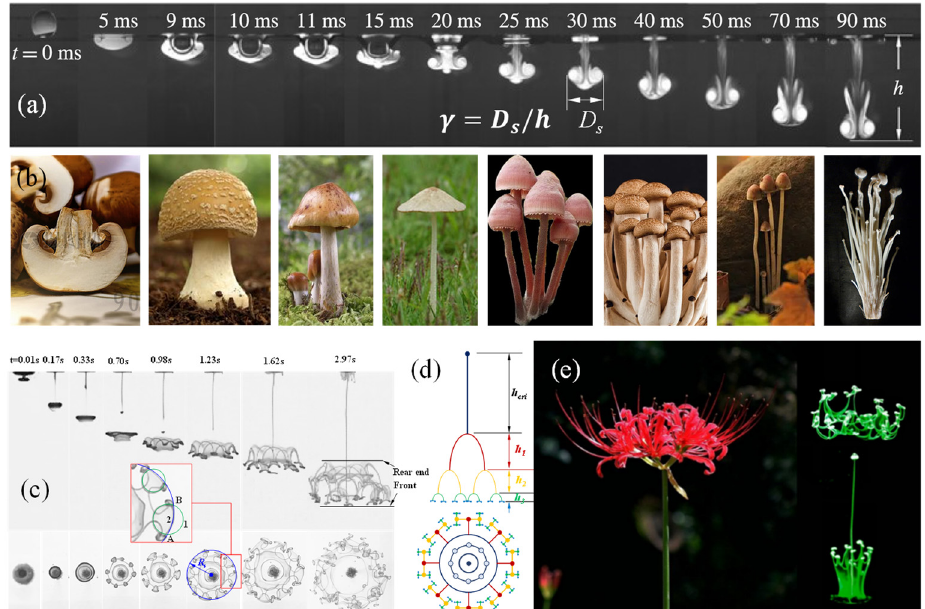
Figure 1. ( a ) Comparison of the morphologies of sinking vortex ring [31] “Reprinted with permission from [Abhishek Saha et al.], [The Journal of Fluid Mechanics]; published by [Cambridge University Press], [2019]” with ( b ) mushrooms, ( c ) High speed images showing side and bottom view of the morphological evolution of the vortex ring and ( d ) its abstract structure, ( e ) Morphologies of manjusaka vs. the bifurcation flower [32]. “Reprinted with permission from [Yajie Zhang et al.], [Physica of Fluids]; published by [AIP Publishing], [2021]”.